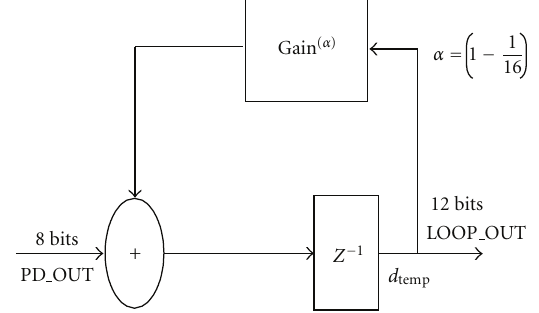
Figure 10: Block diagram of first order loop